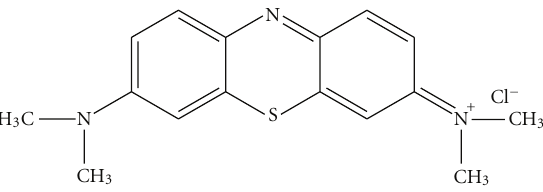
Figure 1: The chemical structure of methylene